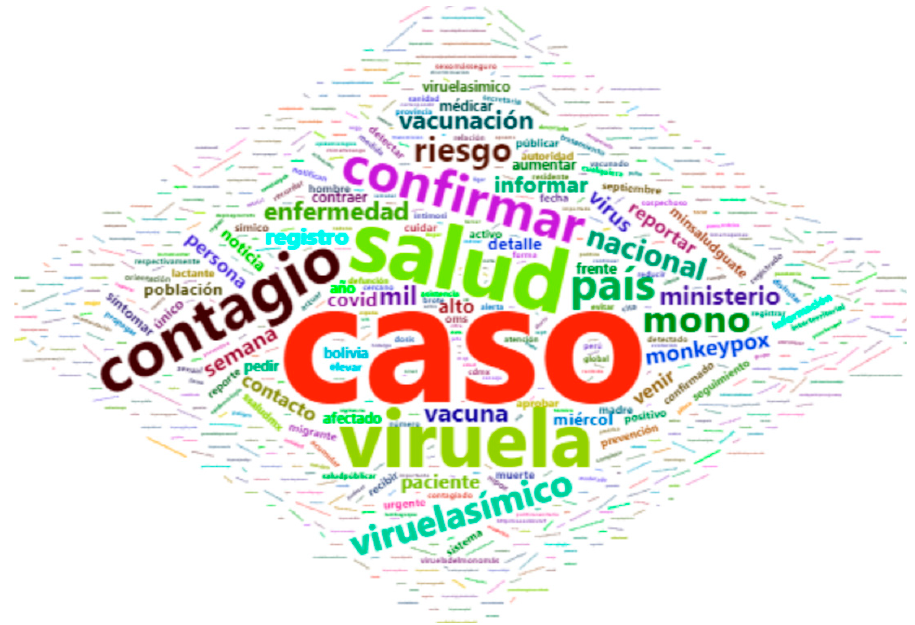
Figure 4. Most frequent words in the